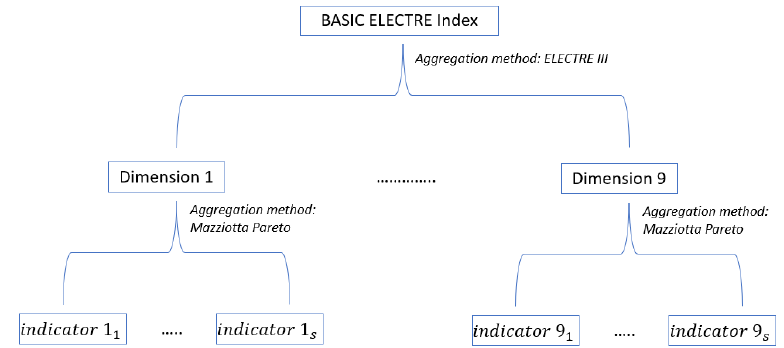
Figure 2. The first variation that we propose: BASIC ELECTRE Index.